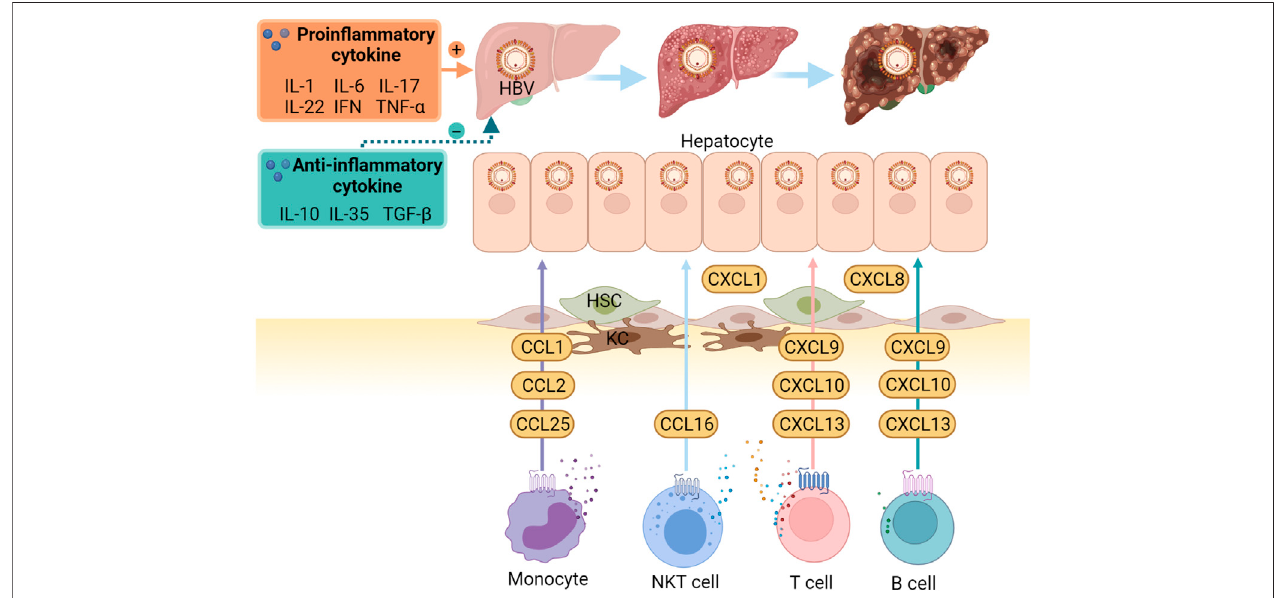
FIGURE1| Important cytokinesand chemokines inthepathogenesisofHBVinfection andHBV-relateddiseases.WhenHBVinvades, localimmunecellsrespond fi rstly, especially the KCs. They induce the production of chemokines and cytokines. CCL1, CCl2, and CCL25 contribute to in fi ltrating monocyte recruitment. CCL16 promotesthemigrationofNKT cells,whereasothers, ligandsofCXCR3andCXCR5, including CXCL9, CXCL10,CXCL13, increasethein fl owofTand Bcellsubsets. In addition, increased intrahepatic CXCL1 and CXCL8 mediate the recruitment of neutrophils. These, together with HSCs changes, result in the disturbance of pro- andanti-in fl ammatorycytokines,contributingtothedevelopmentoflivercirrhosisandhepatocellularcarcinoma.CCL,C-CMotifChemokineLigand;CXCR,C-X-Cmotif chemokine receptor; HBV, hepatitis B virus; HSC, hepatic stellate cell; KCs, Kupffer cells; NKT, natural killer T. (created with